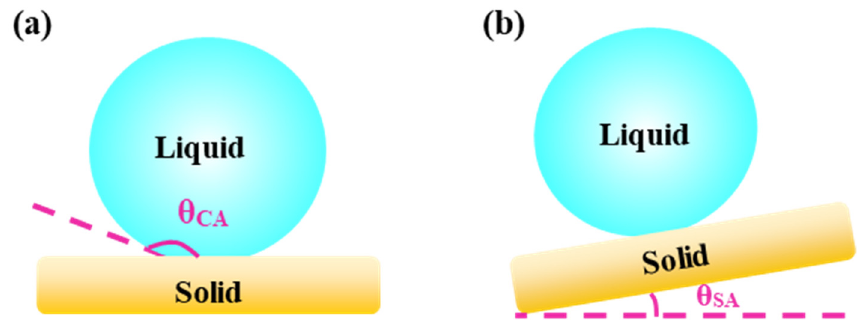
Figure 1. Wetting characterization: ( a ) Contact angle ( θ CA ), ( b ) Rolling angle ( θ RA ).